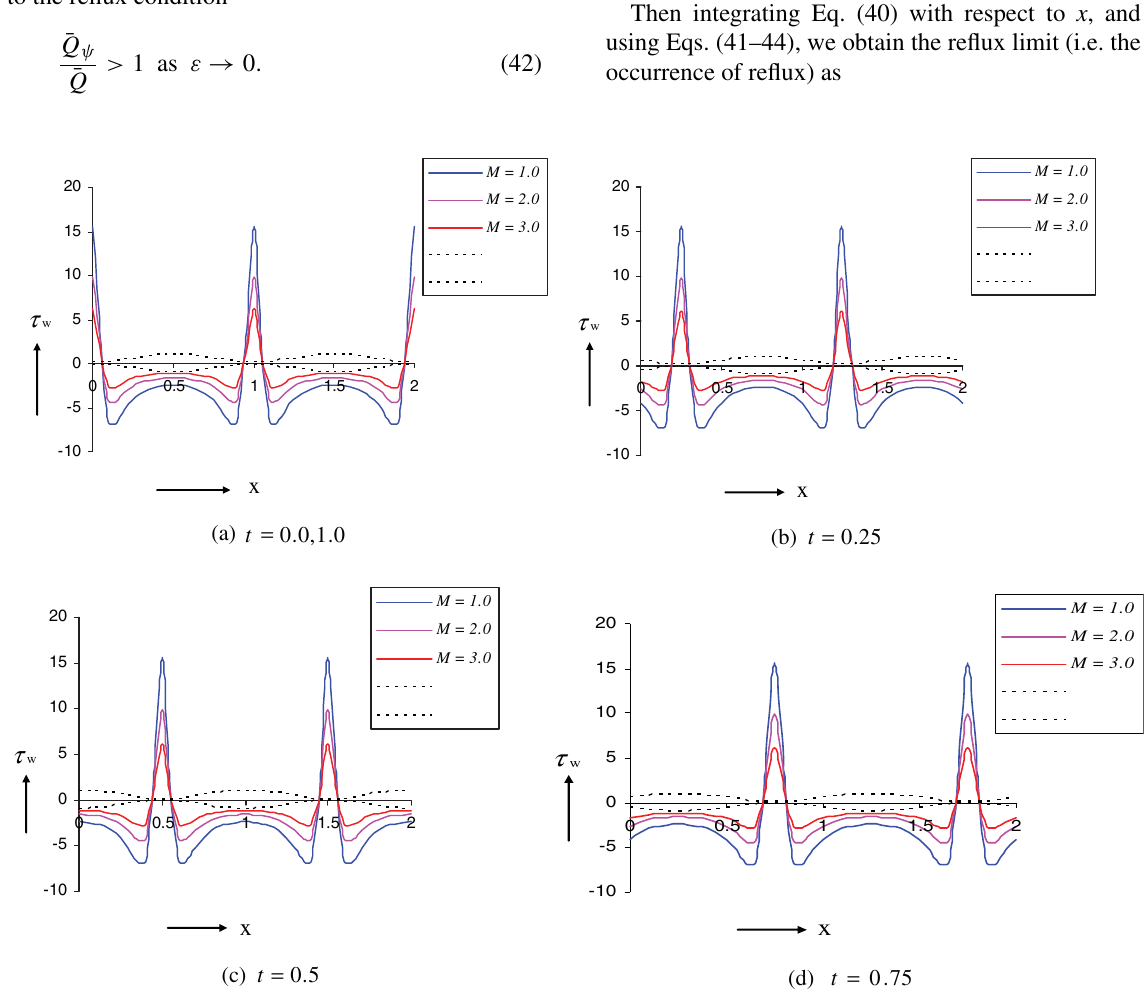
Fig. 7. Pressure distribution by local wall shear stress at five time instants based on Eq. (32). Dotted lines ( ······ ) represent the position of wave, whereas continuous lines (—) represent the local wall shear stress for M =1.0–5.0, φ =0.9, N =0.50 and l